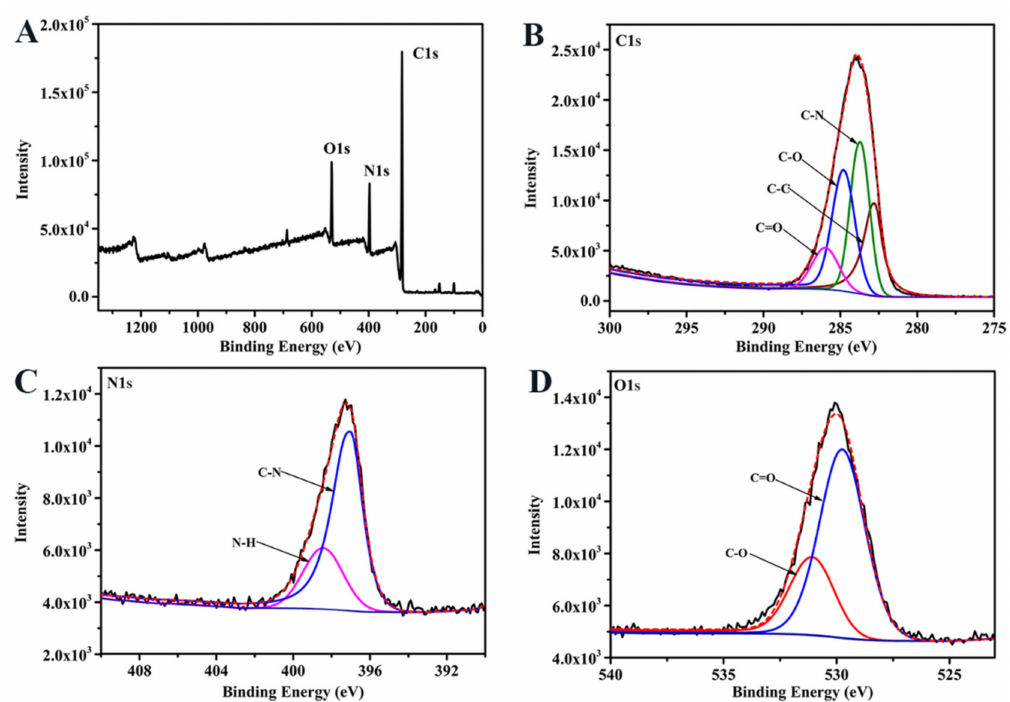
Figure 2. XPS scanning spectrum of CD C-HP ( A ) and high resolution spectrum of C 1s ( B ), N 1s ( C ), and O 1s ( D ).